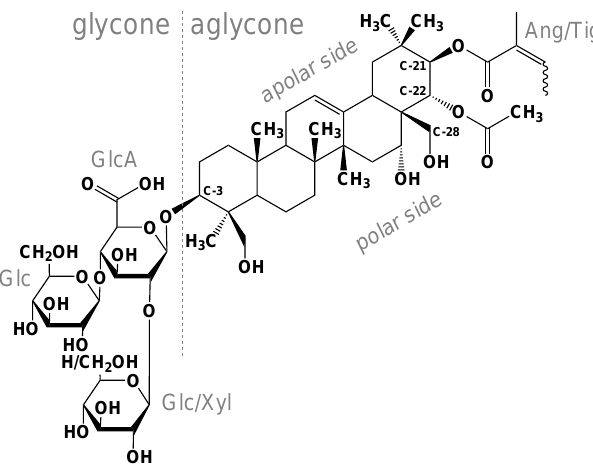
Figure 1. Molecular structure of β -aescin [31,41]. Aescin consists of a well-separated polar glyconic part constituted of three sugar molecules and a triterpenic backbone, which represents the aglyconic part. Polar groups are attached to its backbone one-sided so that the aglycone possesses a slightly polar and an apolar